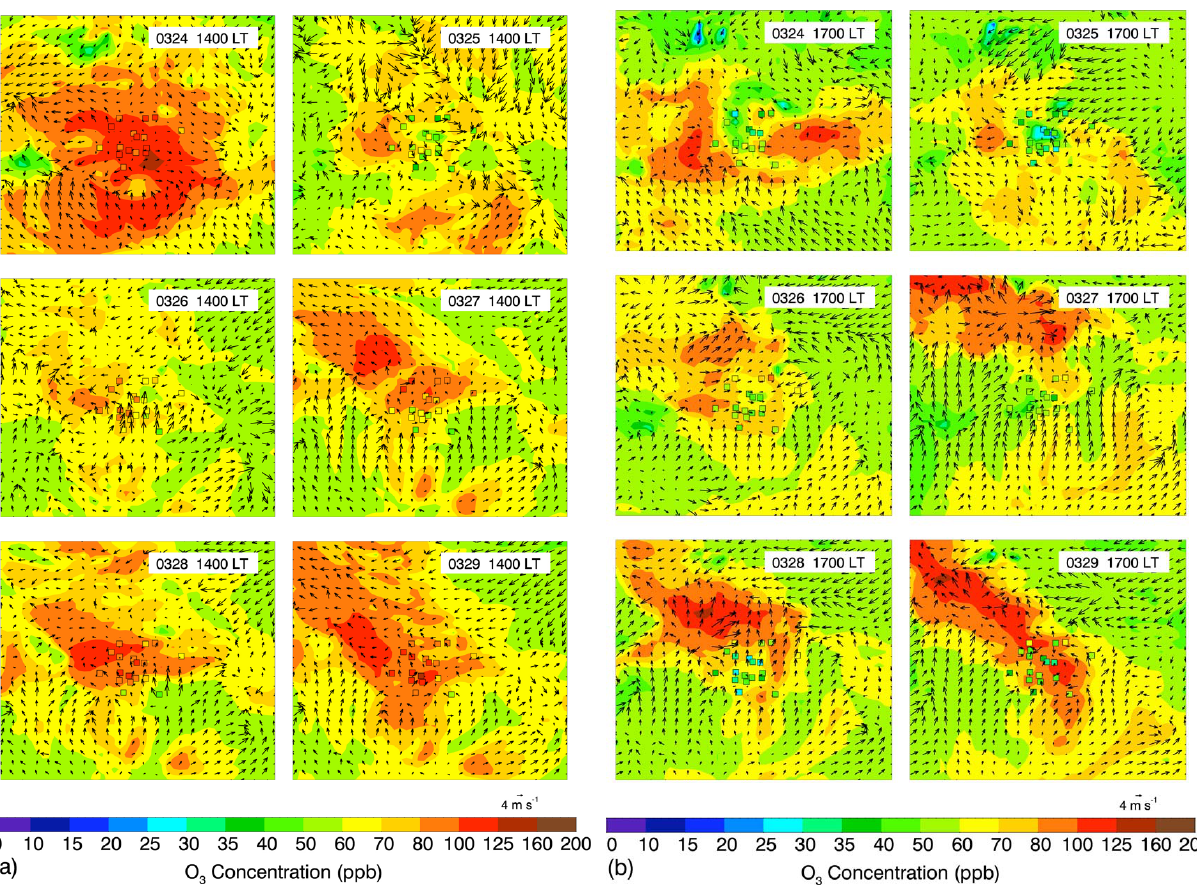
Fig. 2. Pattern comparison of simulated vs. observed O 3 and CO at 14:00 and 17:00LT over Mexico City during the period from 24 to 29 March 2006. Colored squares: O 3 or CO observations; color contour: O 3 or CO simulations in the NT-SOA model; black arrows: simulated surface